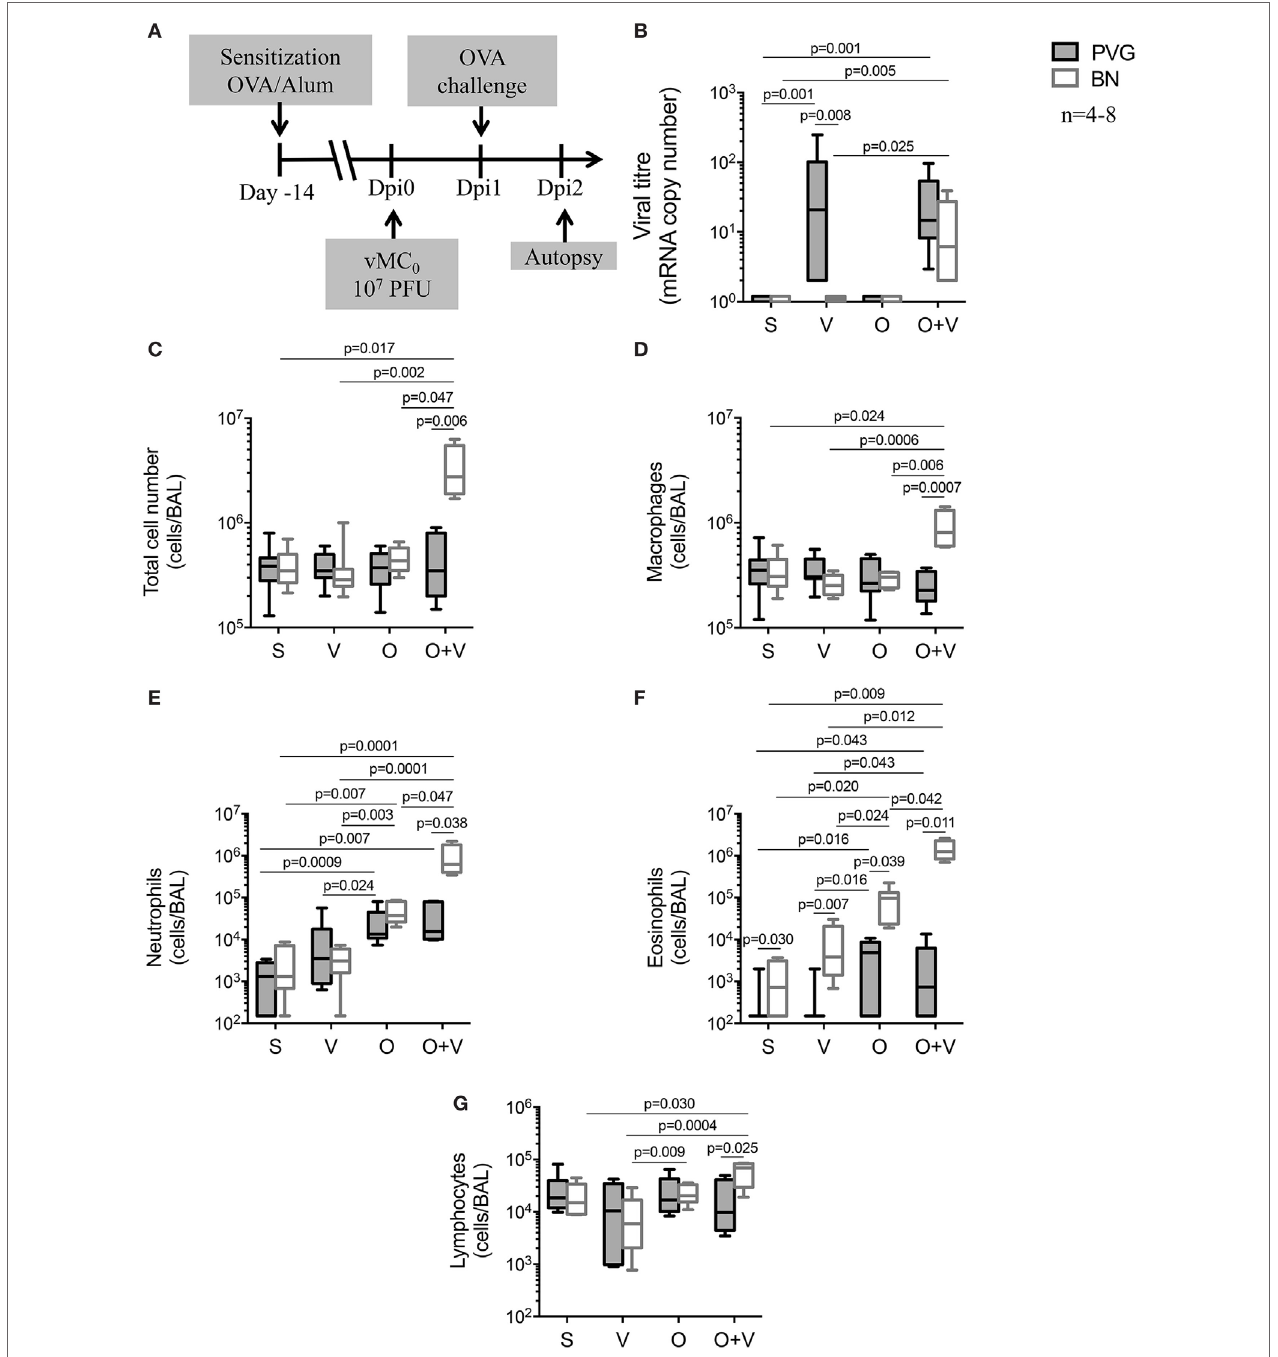
FigUre 4 | vMC 0 infection prior to allergen exposure triggers severe airways disease in BN rats. (a) PVG ( ◾ ) and BN ( ◽ ) rats were sensitized (S) with OVA/alum 14 days prior to vMC 0 infection (V), OVA allergen challenge (O) at day 1 post-infection (Dpi1). (B) Viral titres were measured by real-time quantitative PCR. Bronchoalveolar lavage were collected at Dpi2 and (c) total cell numbers were measured in BAL, as well as (D) macrophages, (e) neutrophils, (F) eosinophils, and (g) lymphocytes. n = 4–8; statistical analysis was carried out by non-parametric Kruskal–Wallis test followed by Dunn’s multiple comparisons [overall p -values for panels (B–g) are respectively: 0.0001; 0.030; 0.025; 0.0001; 0.0001; and